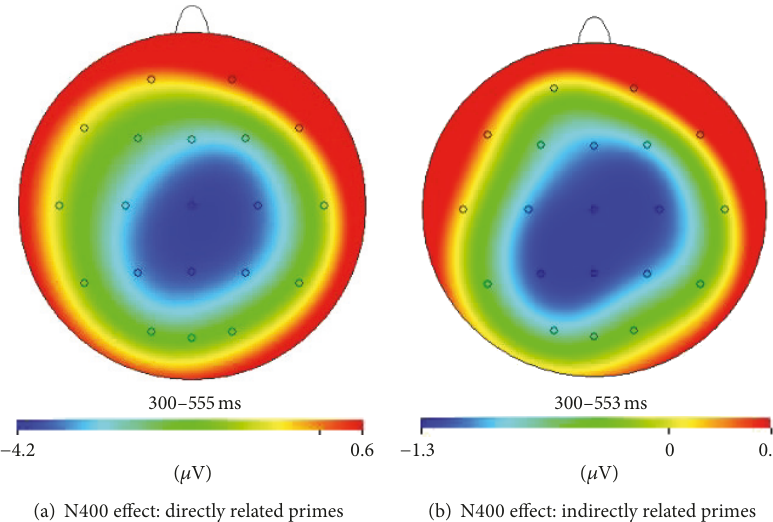
Figure 2: Topographical maps depicting the distribution of (a) direct and (b) indirect N400 priming effect (in microvolts) across the scalp for the concordant healthy control group. The effect was centered around the medial electrode site